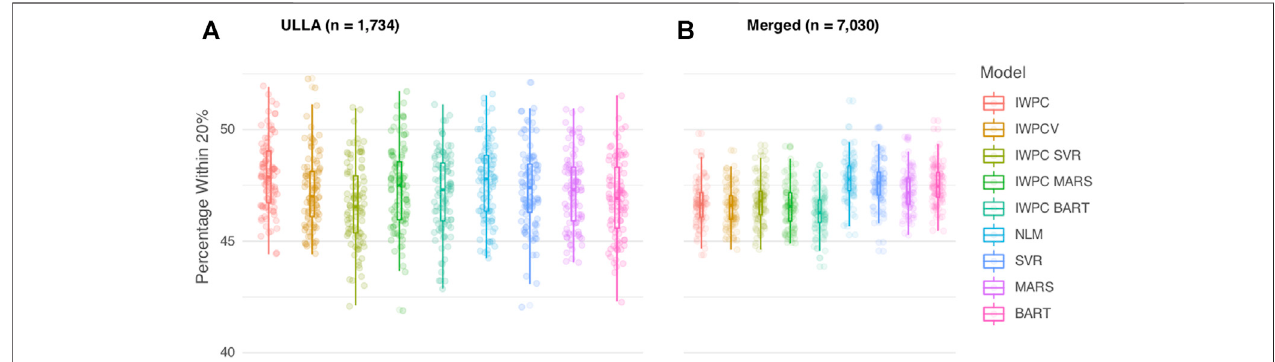
FIGURE 2 | Comparison of Warfarin Dose Prediction Algorithms in the ULLA and Merged cohorts. Proportion of patients predicted within 20% of their actual dose is plotted in the (A) US Latinos and Latin Americans (ULLA) cohort and (B) Merged cohort containing both ULLA and IWPC cohorts. Theboxplot visualizes fi ve summary statistics (the median, 25 and 75% quartiles and two whiskers at 1.5* Interquartile Range). The points indicate the proportion of patients predicted within 20% at each of the 100 rounds of resampling. Models feature IWPC variables or IWPC variables in addition to new predictors. IWPC indicates International Warfarin Pharmacogenetics Consortium model, Merged, IWPC cohort plus ULLA cohort, IWPCV, IWPC variables, IWPC MARS, IWPC variables in a Multivariate Adaptive Regression Splines, IWPC SVR, IWPC variables in a Support Vector Regression, IWPC BART, IWPC variables in a Bayesian Additive Regression Trees, NLM, Novel Linear Model. From left to right, the fi rst fi ve models, IWPC, IWPCV, IWPC_SVR, IWPC_MARS, and IWPC_BART feature the clinical variables age, height, weight, race, enzyme inducer user, amiodarone use and the genetic variables CYP2C9 Diplotype and VKORC1 -1639G > A Genotype, the next four models, NLM, SVR, MARS and BARTfeature the additionalvariables gender, ethnicity, statin use, aspirin use, history ofdiabetes, warfarin indication, thelast model features only the clinical variables from the fi rst set. IWPC indicates International Warfarin Pharmacogenetics Consortium model, IWPCV, IWPC variables, IWPC MARS, IWPC variables in a Multivariate Adaptive Regression Splines, IWPC SVR, IWPC variables in a Support Vector Regression, IWPC BART, IWPC variables in a Bayesian Additive Regression Trees, NLM, Novel Linear Model, Clinical, the IWPC Clinical model.